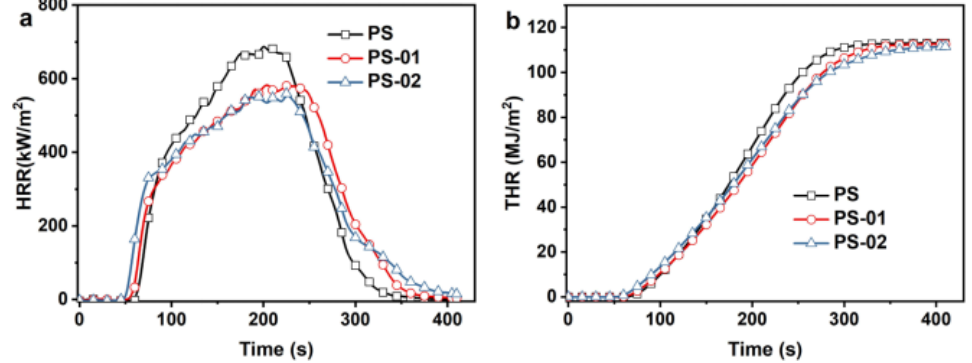
Figure 7. HRR ( a ) and THR ( b ) curves of PS and its blends under a heat flux of 35 kW/m 2 .